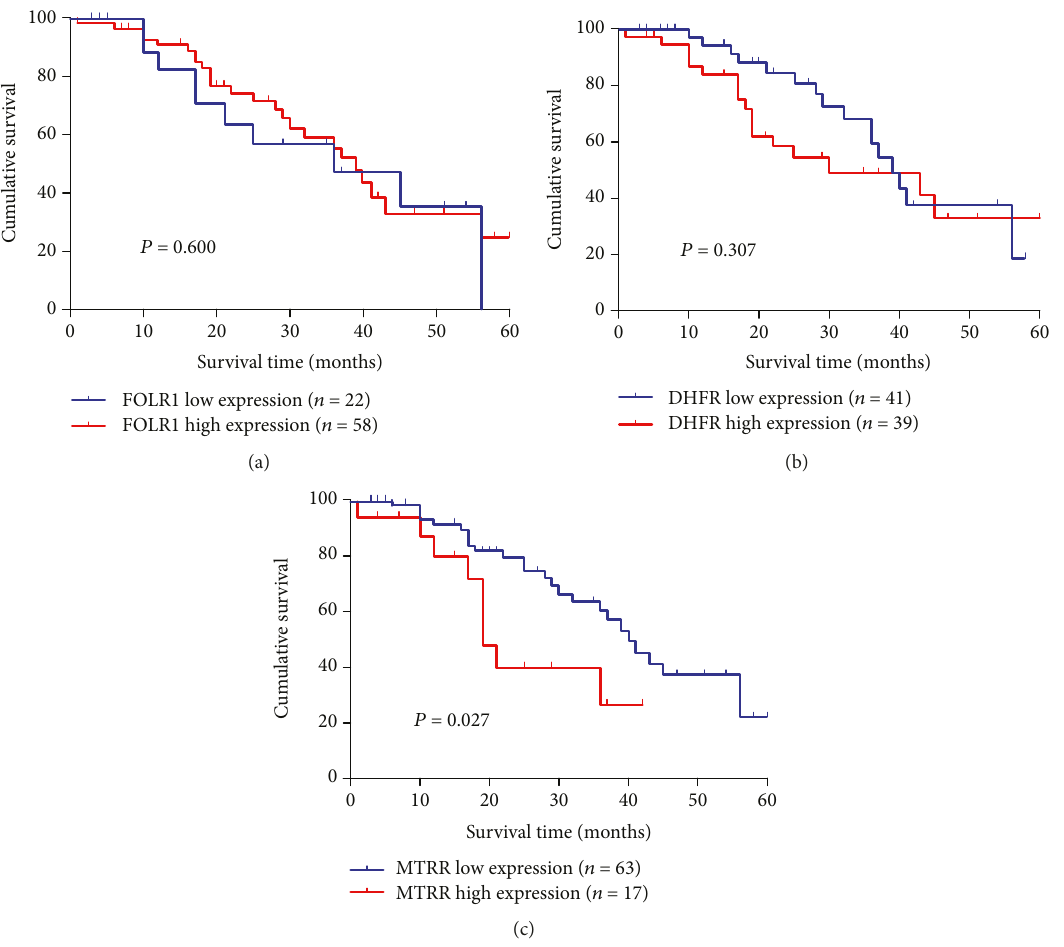
Figure 4: Survival analysis of 80 OC patients by the Kaplan – Meier method. (a) FOLR1 for survival analysis of OC patients; (b) DHFR for survival analysis of OC patients; (c) MTRR for survival analysis of OC patients. Patients with FOLR, DHFR, and MTRR expression higher or lower than average expression are considered as high or low,